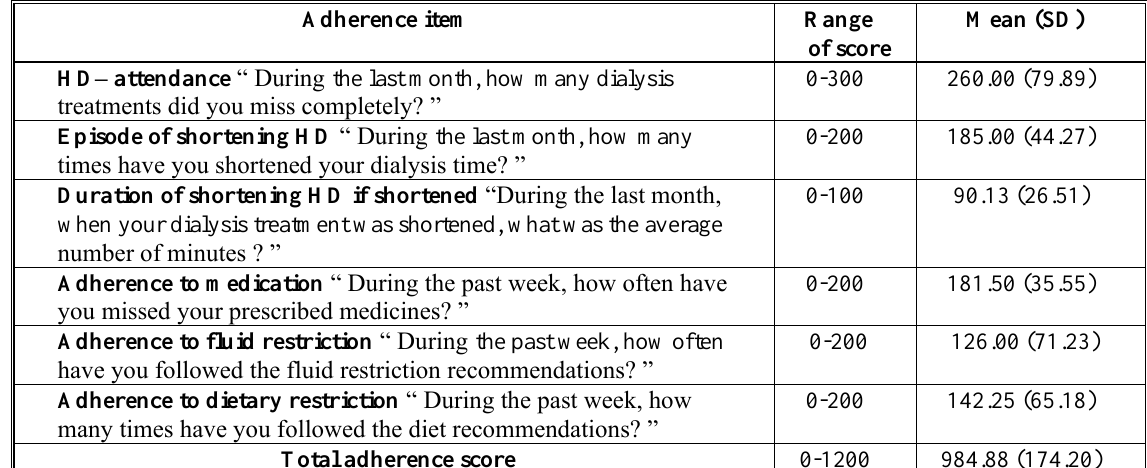
Table 2. Mean (± SD) of adherence score for various treatment modalities. Adherence item